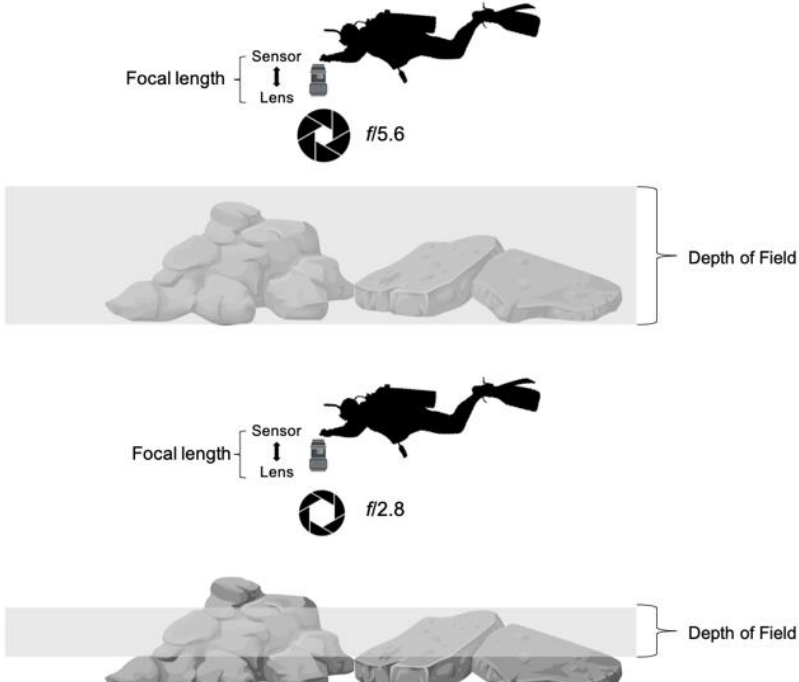
Figure 16. Given the same distance from the substrate, same focal point and focal length, increasing the aperture (smaller f-number) reduces the DoF. The section of the substrate that falls within the grey box would be in focus. In this illustration, an aperture of f /5.6 results in the entire area of interest of the substrate being in focus, while with f /2.8 the top and base of the boulders would be out of focus.